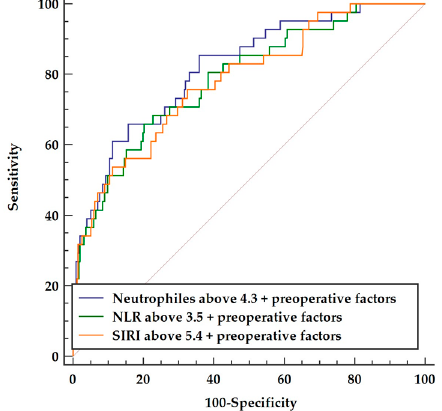
Figure 4. Comparison of three multifactor models including preoperative parameters and postopera- tive neutrophils vs. NLR vs. SIRI, respectively. Abbreviations: NLR—neutrophil-to-lymphocyte ratio, SIRI—systemic inflammatory response